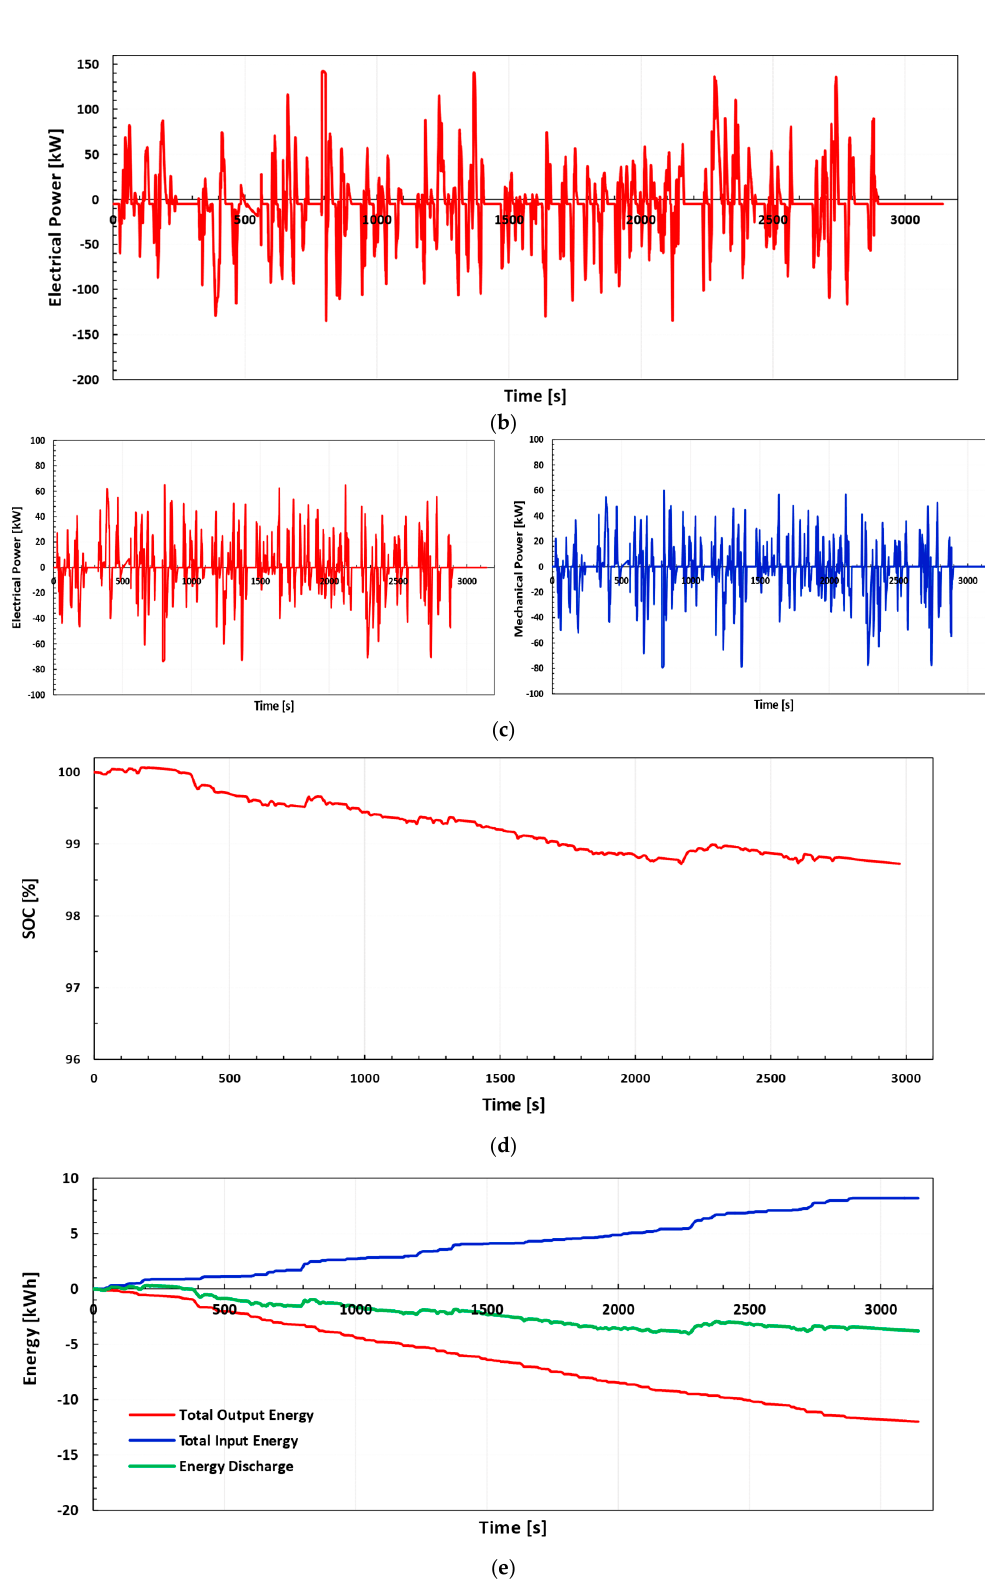
Figure 15. Route 2: ( a ) speed profile and cumulative energy consumption; ( b ) instantaneous power of traction battery; ( c ) electrical (red) and mechanical power (blue); ( d ) state of charge consumption during the cycle; ( e ) energy consumption during the cycle.